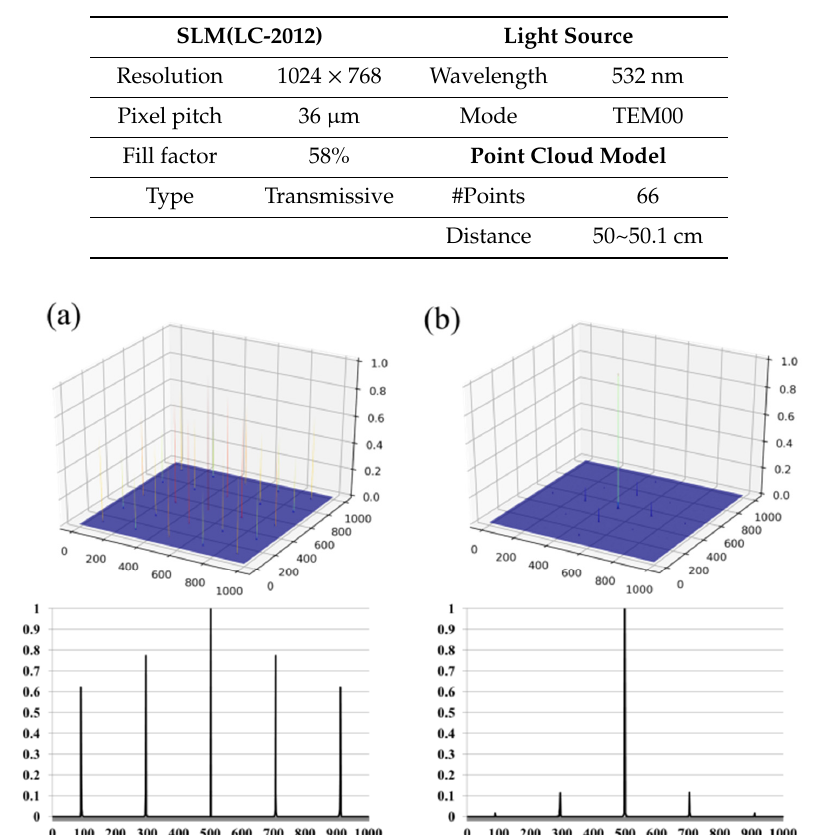
Table 1. Experimental conditions.